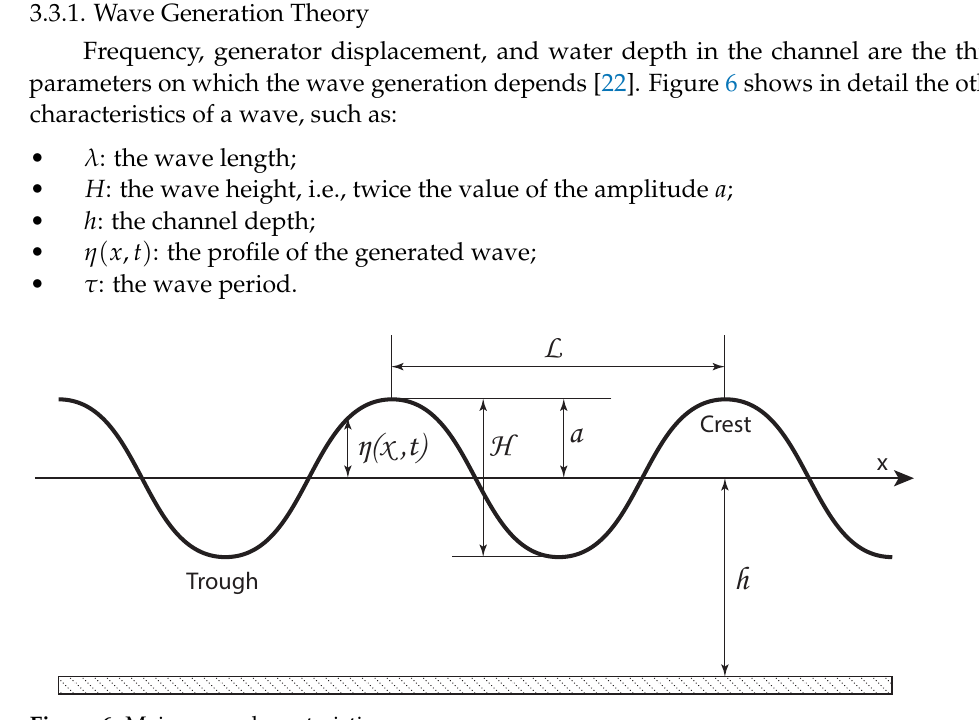
Figure 6. Main wave